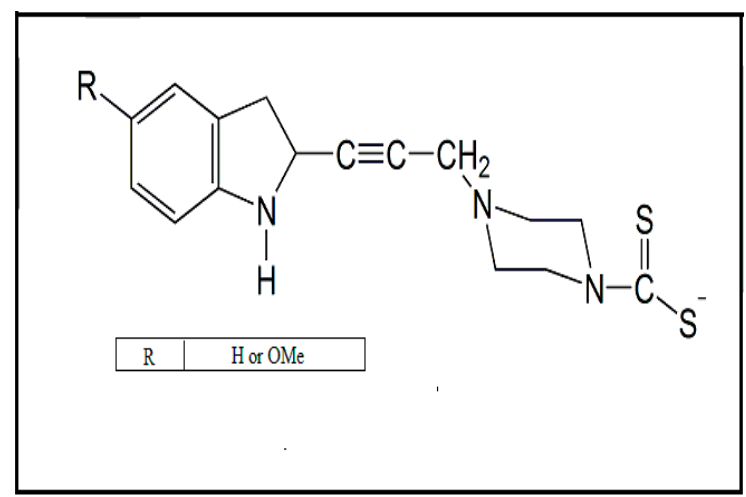
Figure 4. Chemical compounds synthesized from tryptophan with dithiocarbamates used as antiparasitic drugs against Leishmania donovani and Trypanosoma cruzi . In this figure is possible that different substituents (R: H or OMe) interact with the structure formed for tryptophan-dithiocarbamate. These structures are more efficient in inducing mitochondrial damage and consequently parasite death [47].